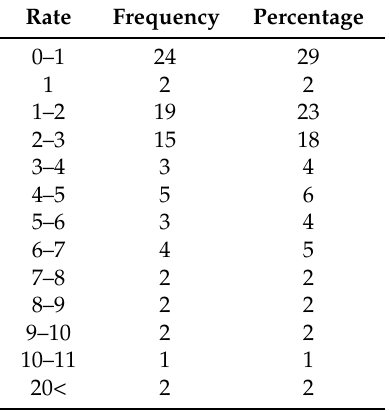
Table 3. Normalized frequency and percentage of Jordan Lake farmers’ willingness to trade (WTA—willingness to accept /installation and opportunity